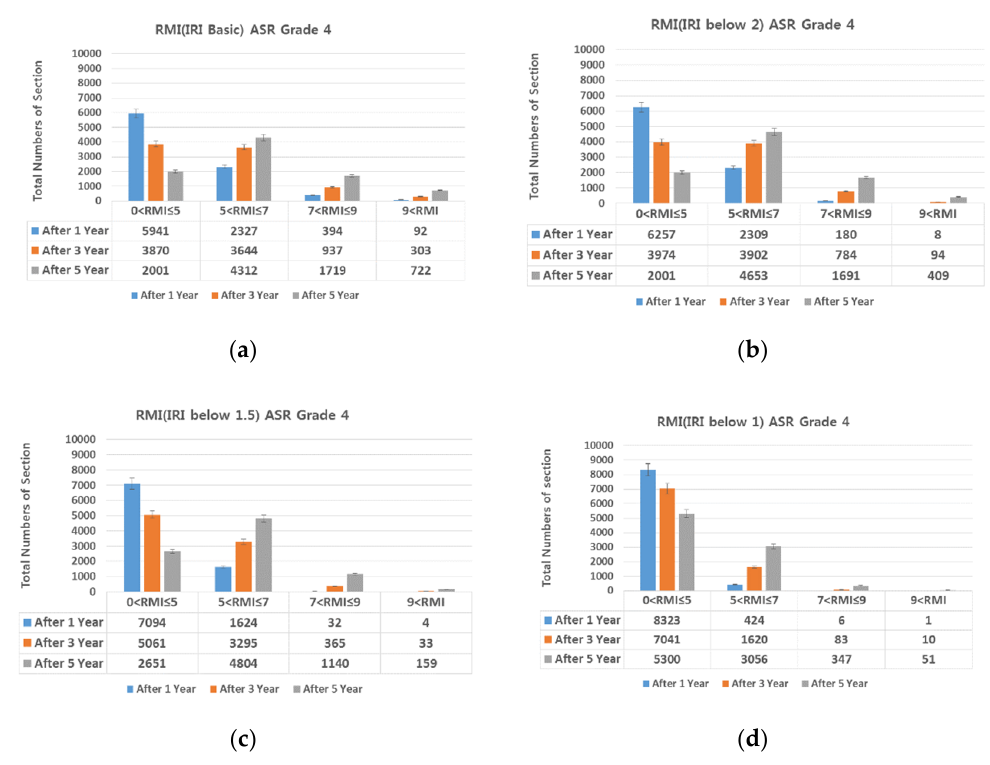
Figure 14. Change in number of sections per RMI with respect to IRI. ( a ) basic IRI and ASR grade 4; ( b ) IRI 2.0 and ASR grade 4; ( c ) IRI 1.5 and ASR grade 4; and ( d ) IRI 1 and ASR grade 4.